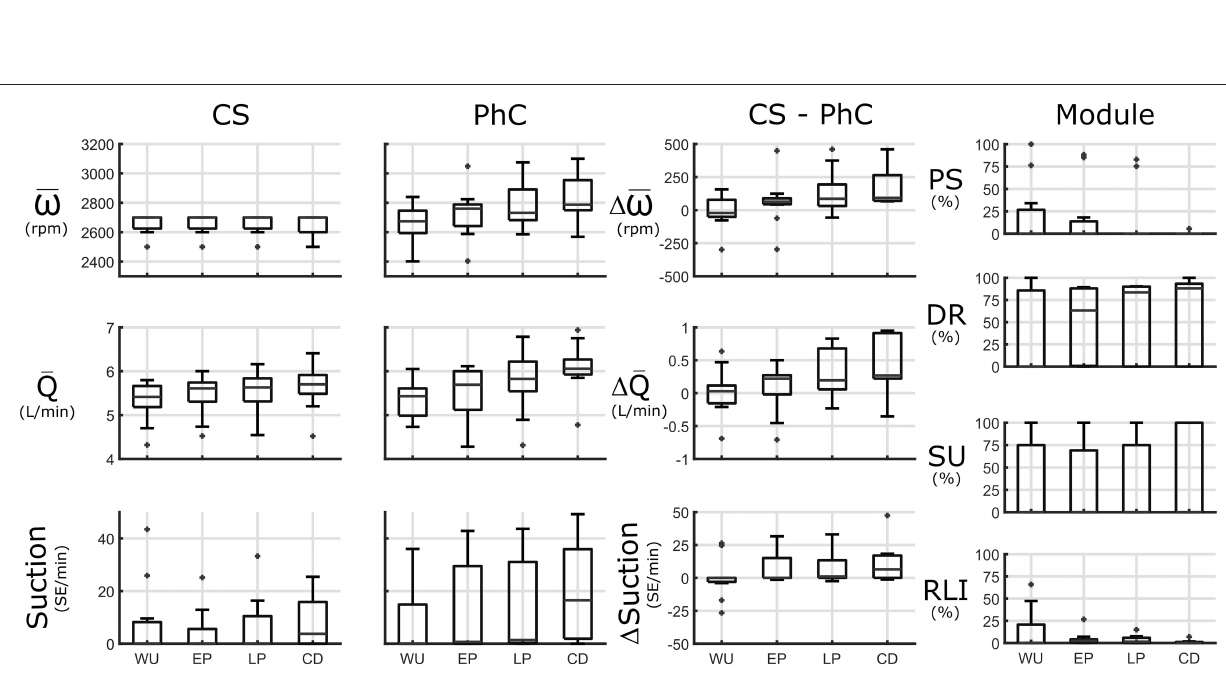
Frontiers in Cardiovascular Medicine |